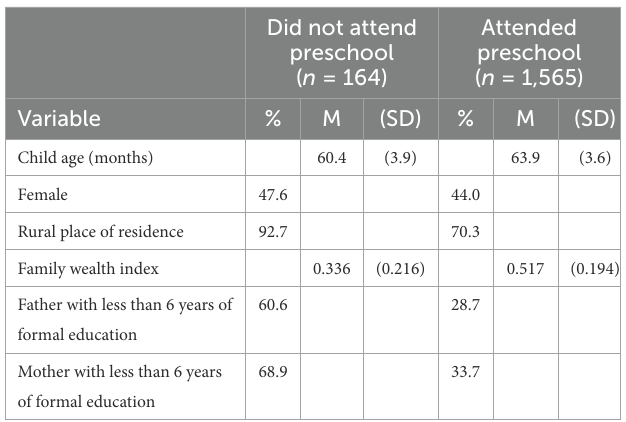
TABLE 6 Demographic characteristics of Vietnamese children who did and did not attend